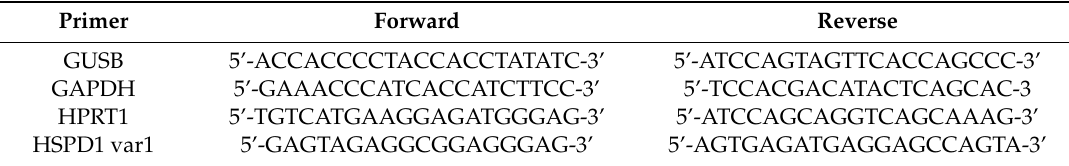
Table 2. Forward and reverse primers used for quantitative real-time PCR